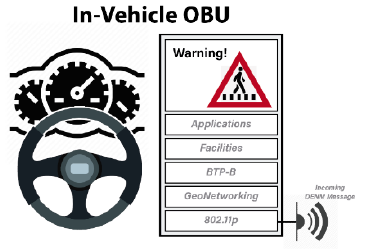
Figure 5. Vehicle onboard unit (OBU) in-vehicle DENM messages reception and presentation.